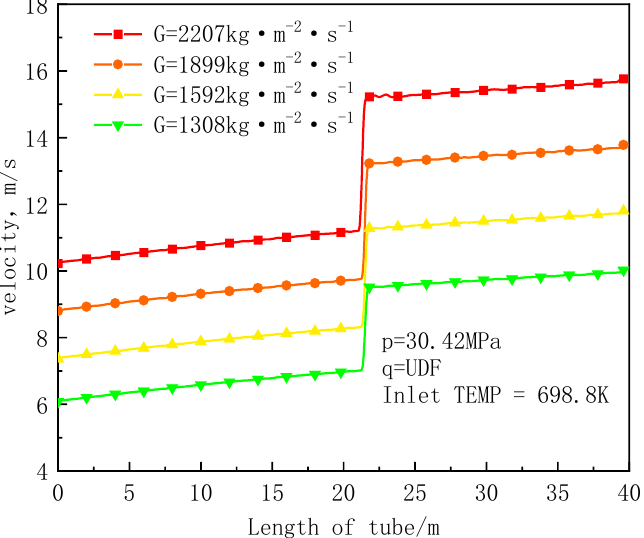
Figure 12. Velocity distribution of tube length at different mass fluxes ( p = 30.42 MPa, T = 718.8 K, G = 1308~2207 kg/ ( m 2 ·s)).